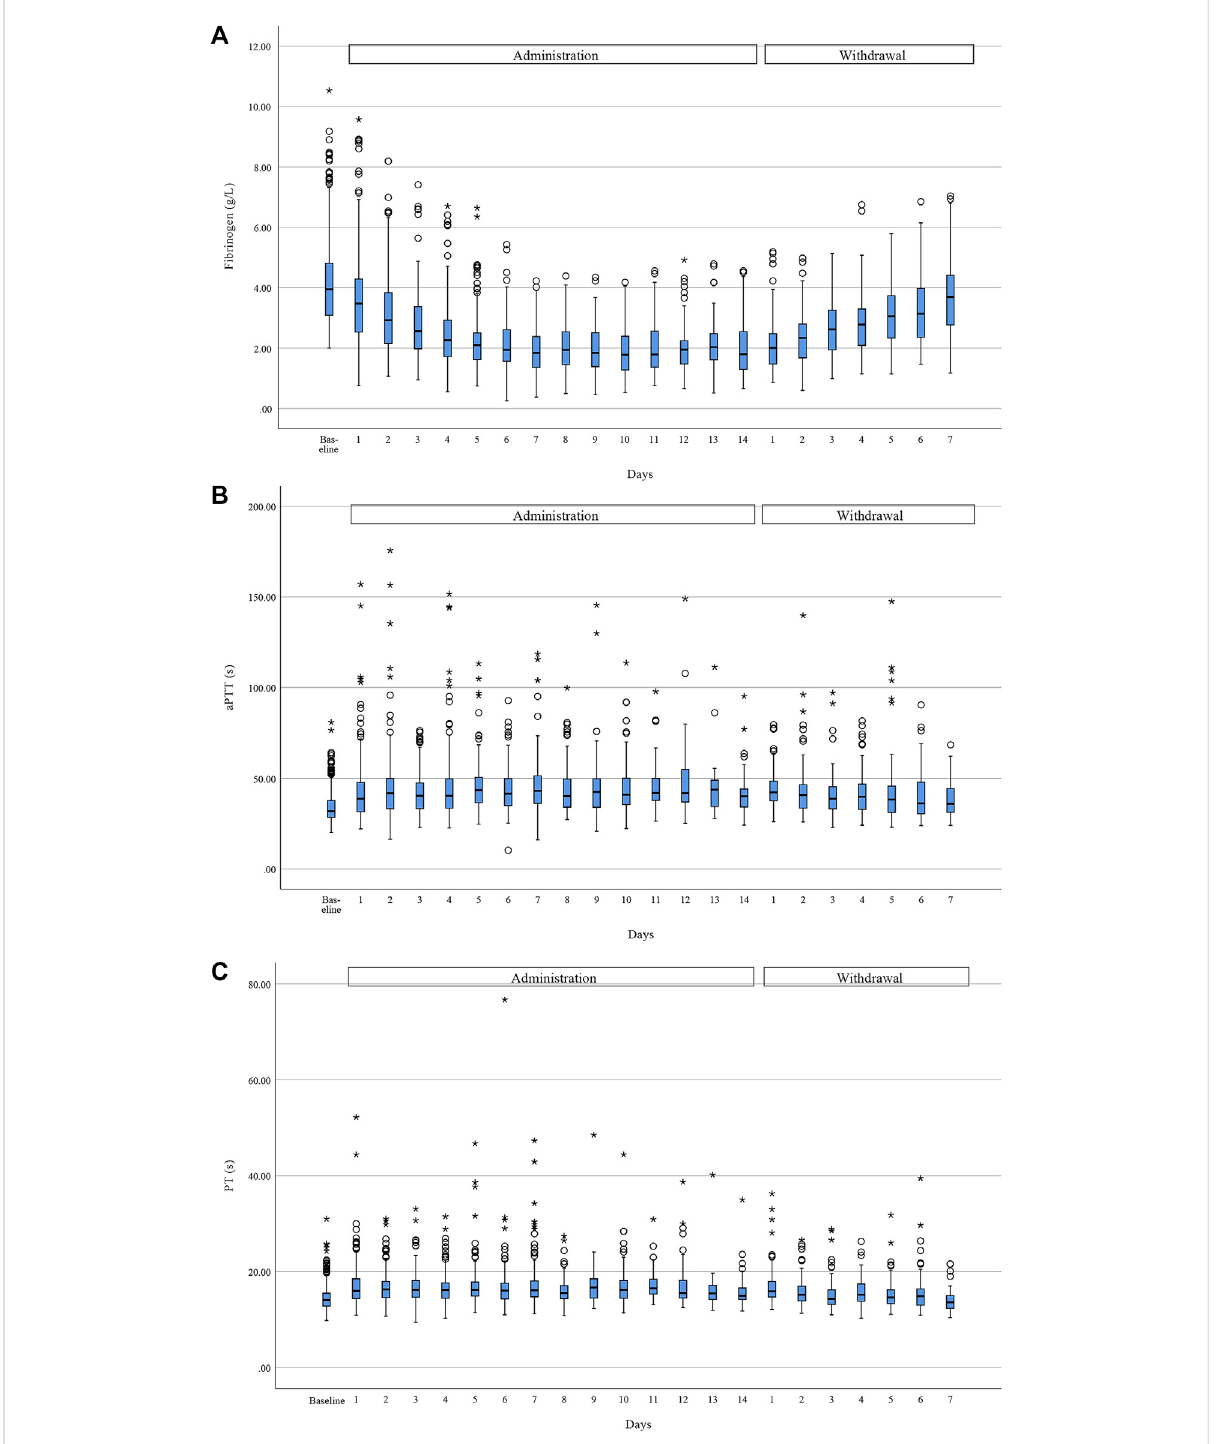
FIGURE 2 Trend of coagulation function during tigecycline administration and after withdrawal. Fibrinogen (A) showed a downward trend during administration and a rebound after withdrawal, while aPTT (B) and PT (C) rose during treatment and fell after withdrawal. Horizontal bars represent themedianvalue,boxes representtheinterquartilerange,whiskersrepresentthe5thand95thpercentilesandhollowcircleandasterisk indicatethe outlier. (Due to the different course of administration and the relatively few data at the late stage of administration and withdrawal, we only showed trend of coagulation for the fi rst 14 days of administration period and the fi rst 7 days after